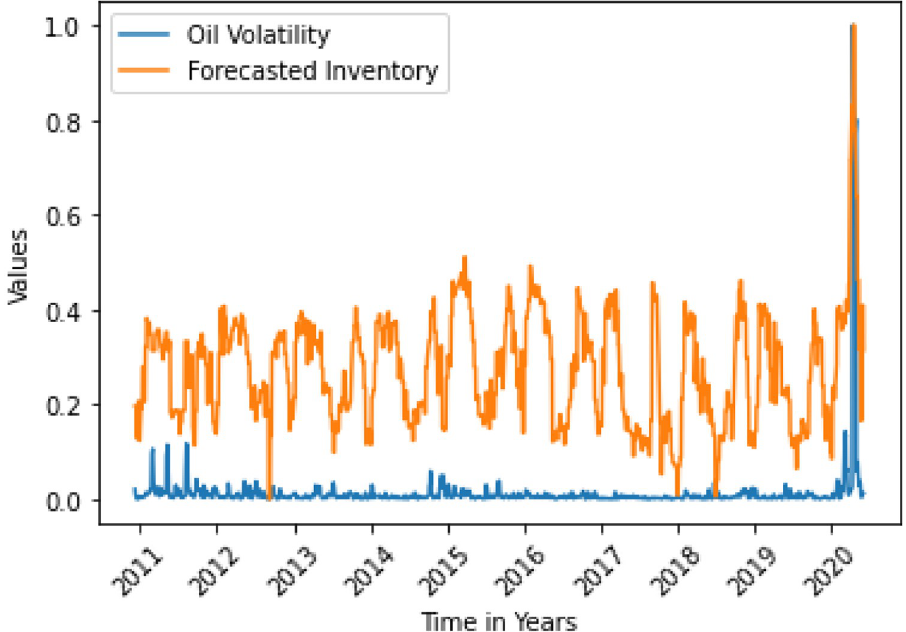
Fig 6. Forecasted inventory granger causes oil variance. Here, the correlation between two data is 0.3785.